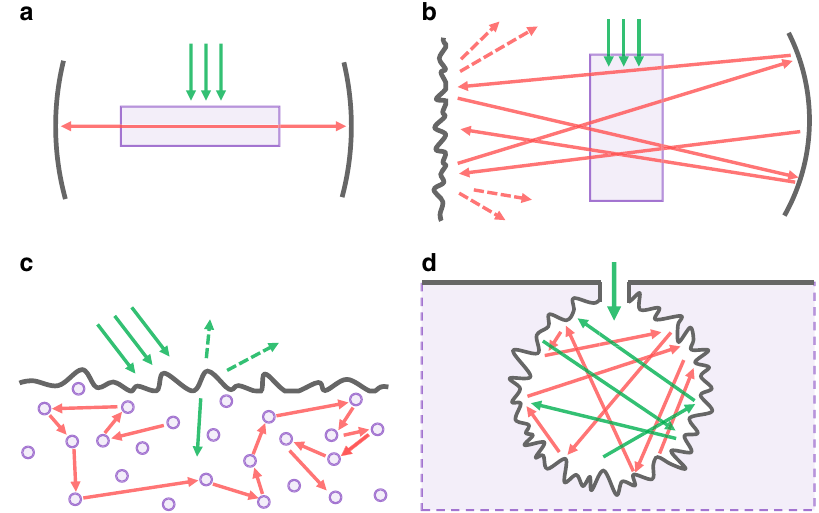
Fig. 1 Different types of lasers. a Conventional coherent laser with a two-mirror resonator. b First NRL demonstrated in ref. 1 . One mirror is replaced with the scattering medium. c Random laser. The scattering medium provides gain and non-resonant feedback simultaneously. d Proposed ‘ spherical light-trap ’ design, consisting of a non-resonant spherical scattering cavity. The scattering medium encapsulates the cavity so that light cannot escape easily. The green and red arrows indicate the pumping and emission light,